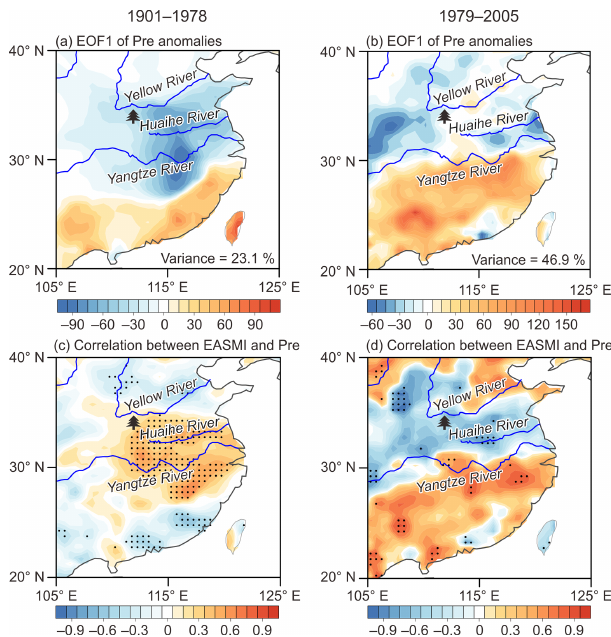
Figure 9. Comparison between the decadal and longer fluctua- tions of May–July (a) EASMI (Zhao et al., 2015), (b) reconstructed scPDSI, (c) precipitation (Pre; GPCC v7; Schneider et al., 2015), and (d) mean temperature ( T mean ; CRU TS 4.01; Harris et al., 2014) over the area of reconstruction. (e) The 21-year moving Pearson correlation coefficients of the decadal-filtered EASMI with scPDSI (black), and Pre (red). (f) The 21-year moving Pearson correlations of the decadal filtered scPDSI with Pre (black), and T mean (red). The decadal and longer fluctuations were derived using the adaptive 10- point Butterworth low-pass filter with 0.1 cutoff frequency (Mann, 2008). Statistically significant ( p < 0 . 05) correlations are denoted as squares, which were tested using the Monte Carlo method (Efron and Tibshirani, 1986; Macias-Fauria et al., 2012).